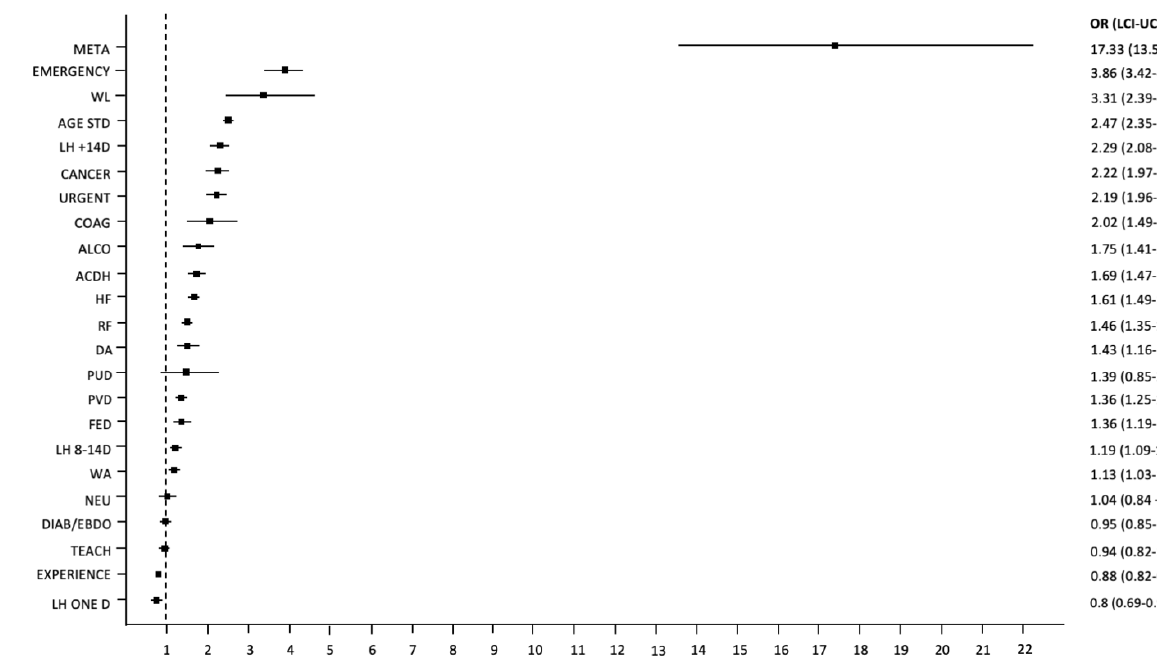
Figure 4. Odds ratios with 95% confidence intervals (represented by bars) for the variables used in the model that may